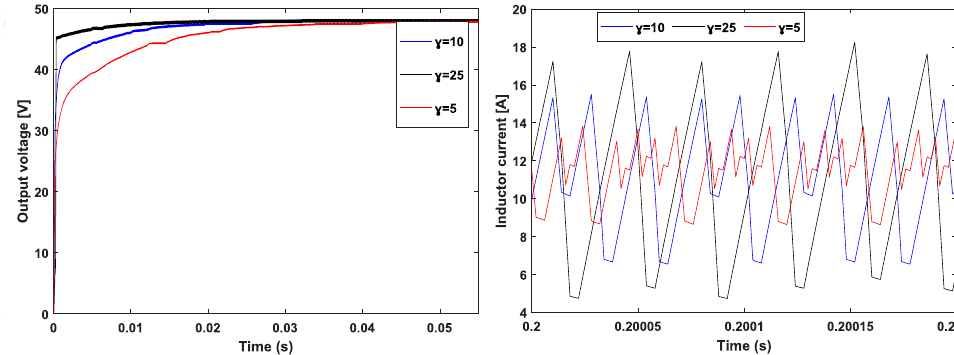
Figure 7. The effect of γ on state variables.